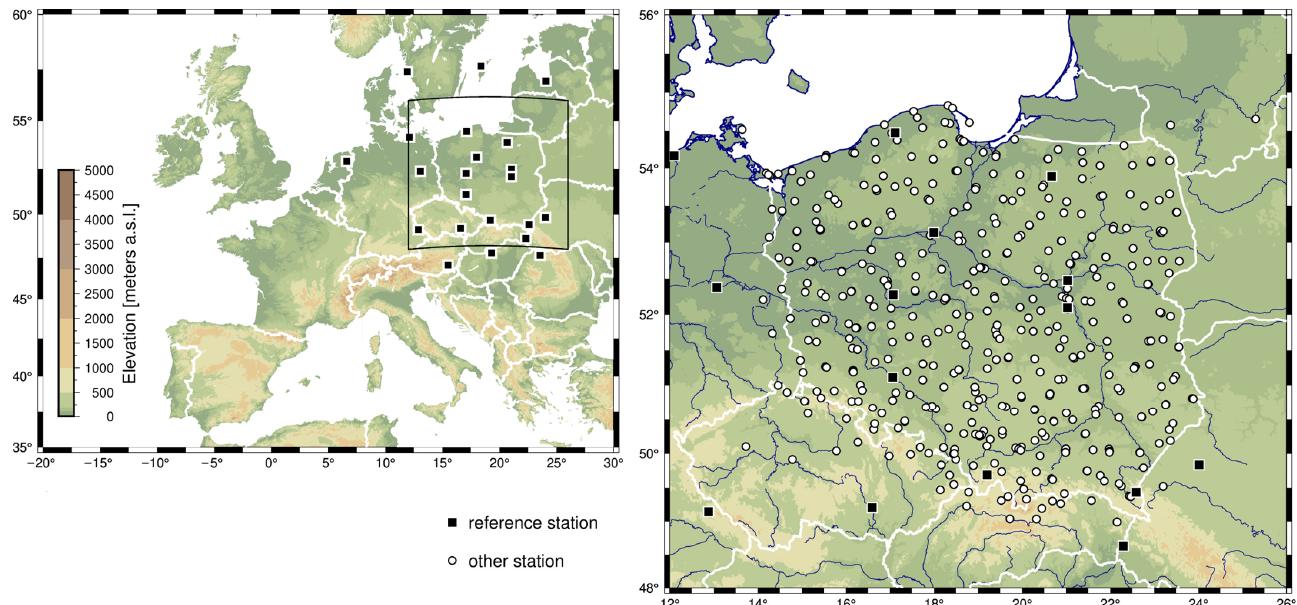
Figure 2. Maps of analysis and distribution of GNSS stations. Black squares indicate stations used as references and are shown on both maps. Two station are located beyond the map area.